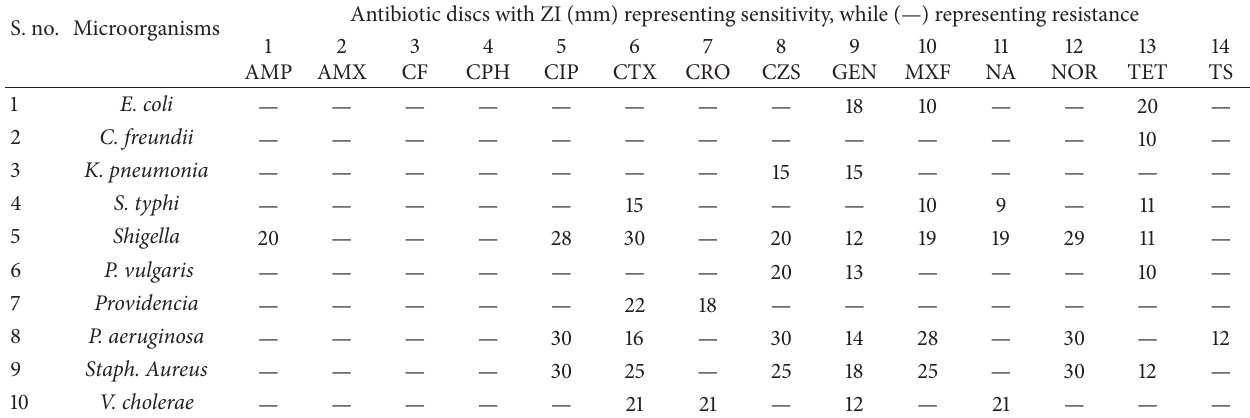
Table 3: Drug resistance pattern of the test-bacterial